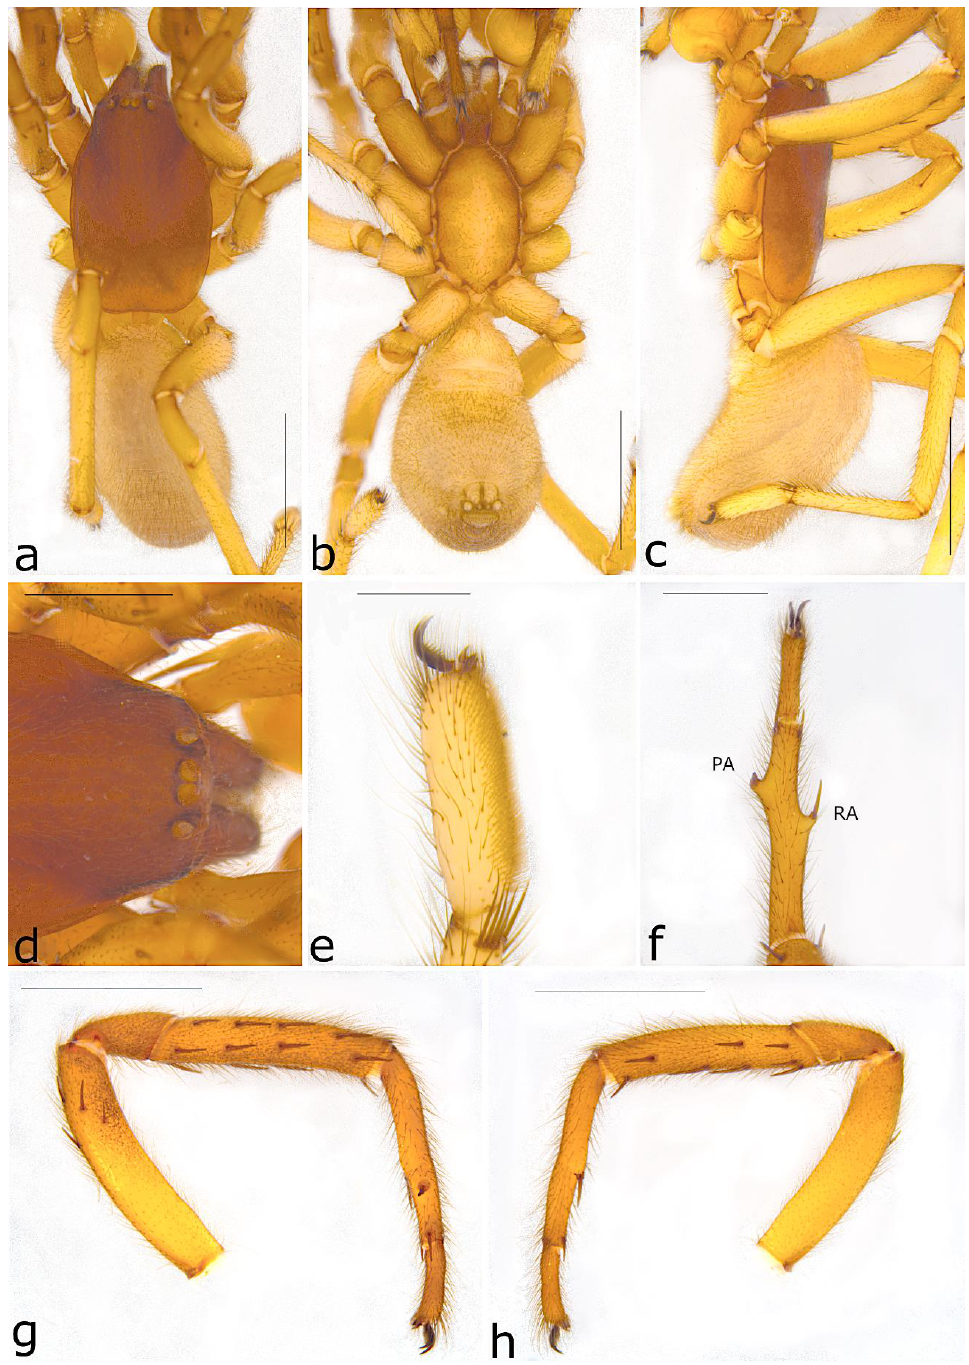
Figure 65. Ariadna ungua sp. nov. ♂ holotype (SAMA NN30481) from Lake Dam, near Lake Frome/Munda (SA): ( a ) habitus, dorsal view; ( b ) same, ventral view; ( c ) same, lateral view; ( d ) eyes, dorsal view; ( e ) left metatarsus IV, preening comb, retrolateral view; ( f ) left leg I, ventral view; ( g ) same, prolateral view; ( h ) same, retrolateral view. Scale bars ( a – c ) = 2 mm, ( d ) = 1 mm, ( e ) = 0.5 mm, ( f ) = 1 mm and ( g , h ) = 2 mm.